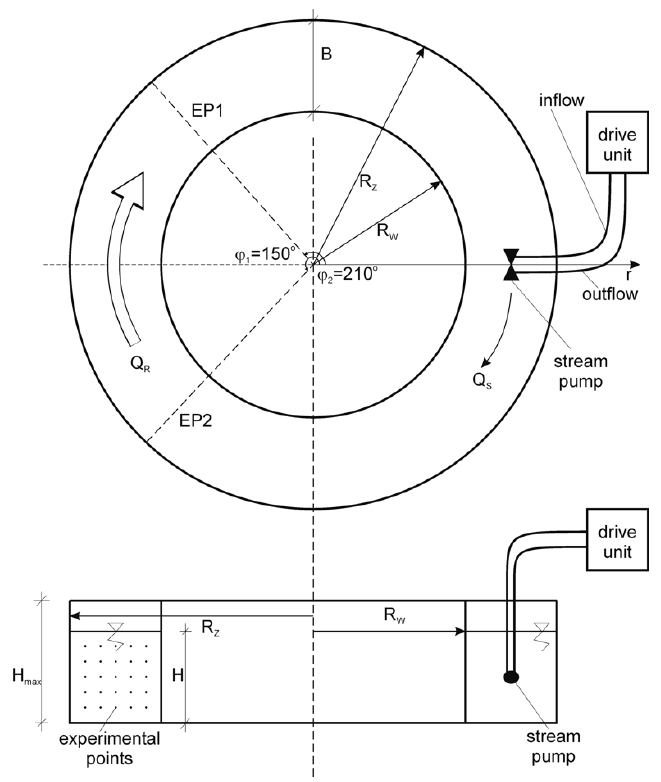
Figure 6. Comparison of calculated and measured results.